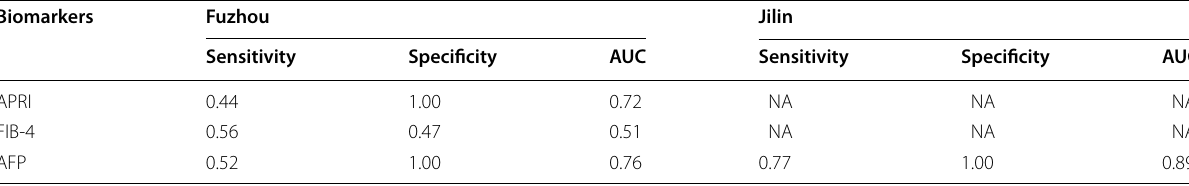
NA indicated not applicable